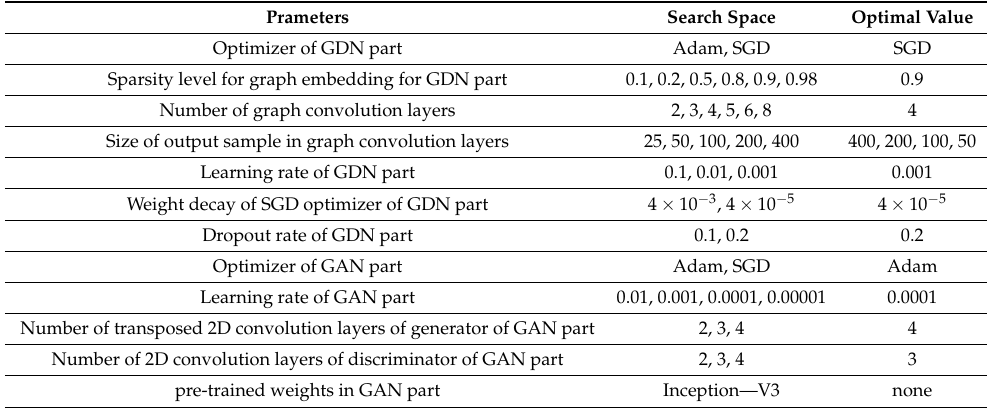
Table 4. Search space for selecting the optimal parameters for the proposed GDN-GAN. Prameters Search Space Optimal